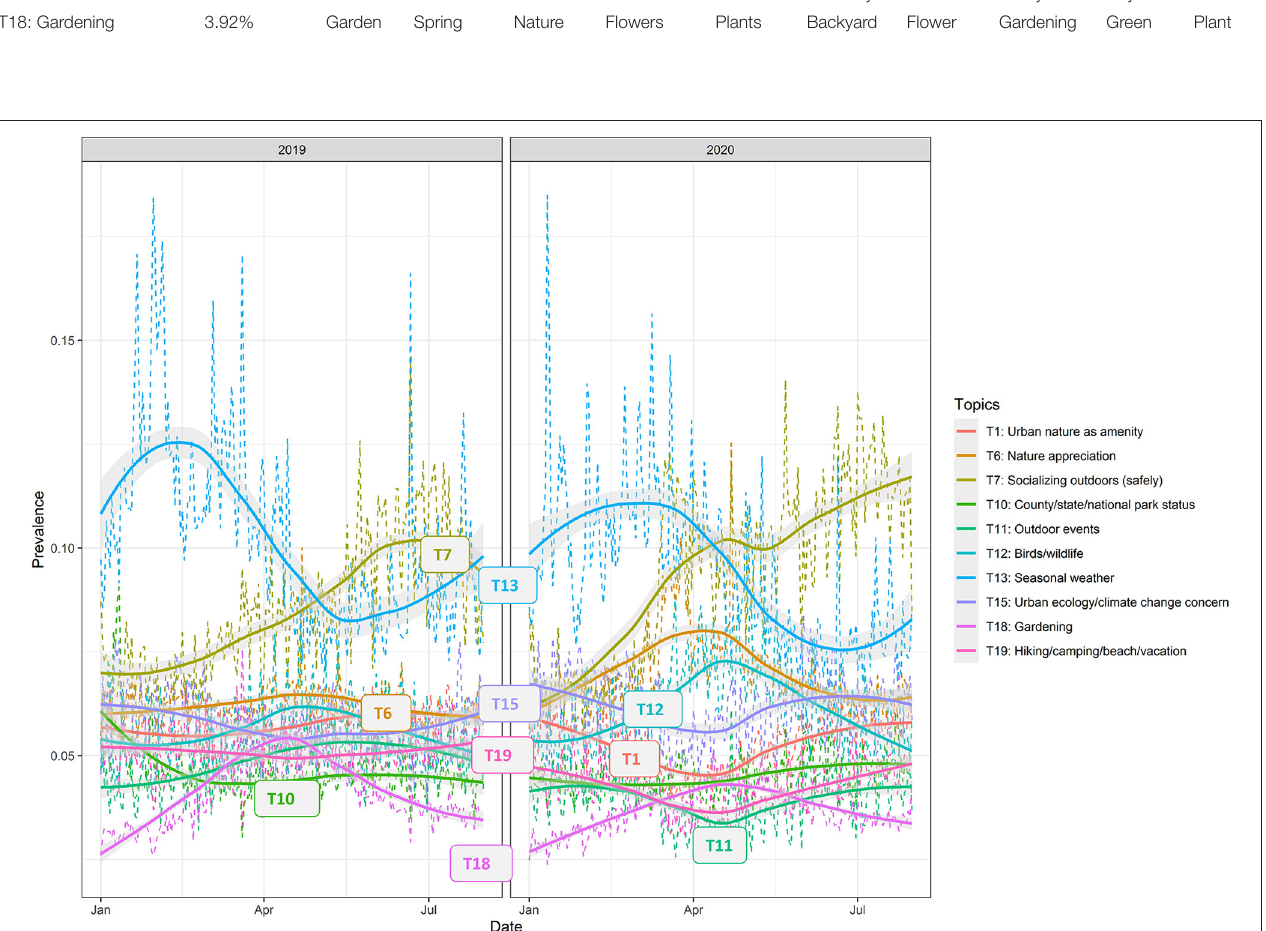
FIGURE 2 | Prevalence of nature-based topics within Twitter dataset in 2019 and 2020.